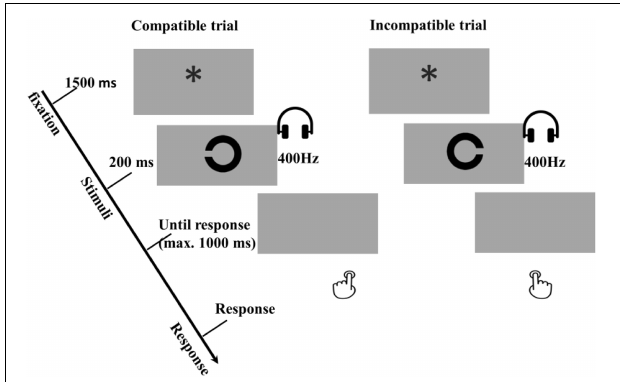
FIGURE 6 | Examples of compatible and incompatible conditions in the trial-based interference test phase of Experiment 3a and 3b. In these examples a low tone of 400 Hz was mapped to a left response, which depending on the R-O mapping in the acquisition phase. All other combinations were possible, but are not presented in this figure. The main task is the orientation discrimination task with the tones as primes, and the compatible and incompatible are intermixed in trials